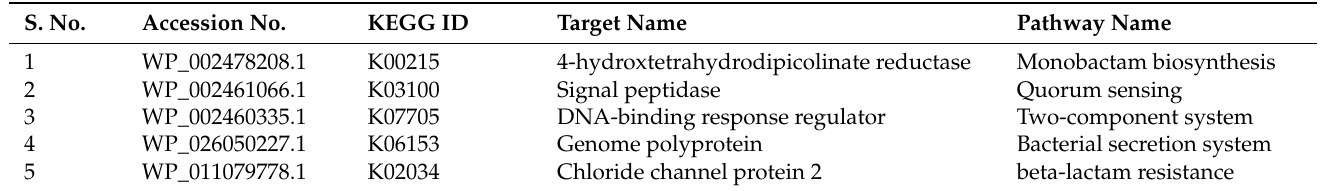
Table 4. Non-homologous, essential, and virulent druggable targets of S. lugdunensis .